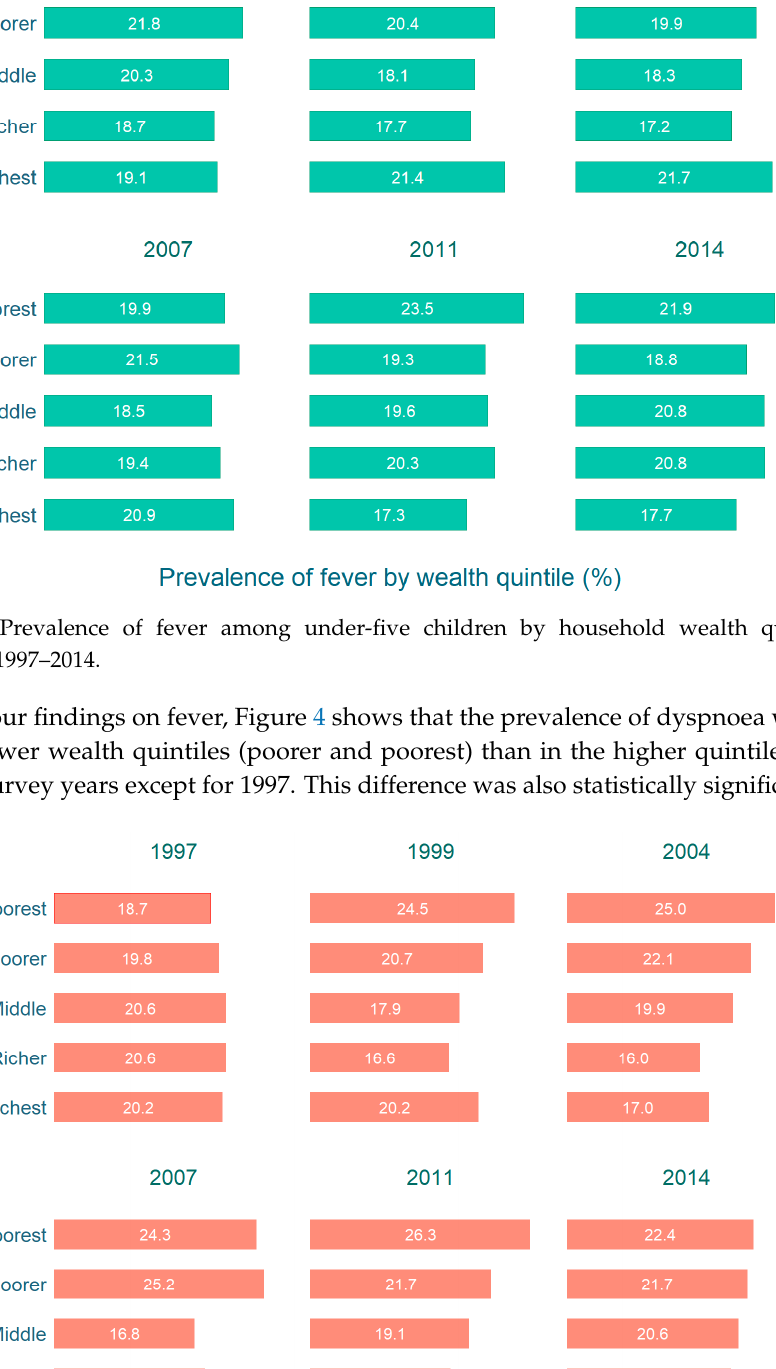
Figure 4. Prevalence of dyspnoea among under-five children by household wealth quintile in Bangladesh 1997–2014.